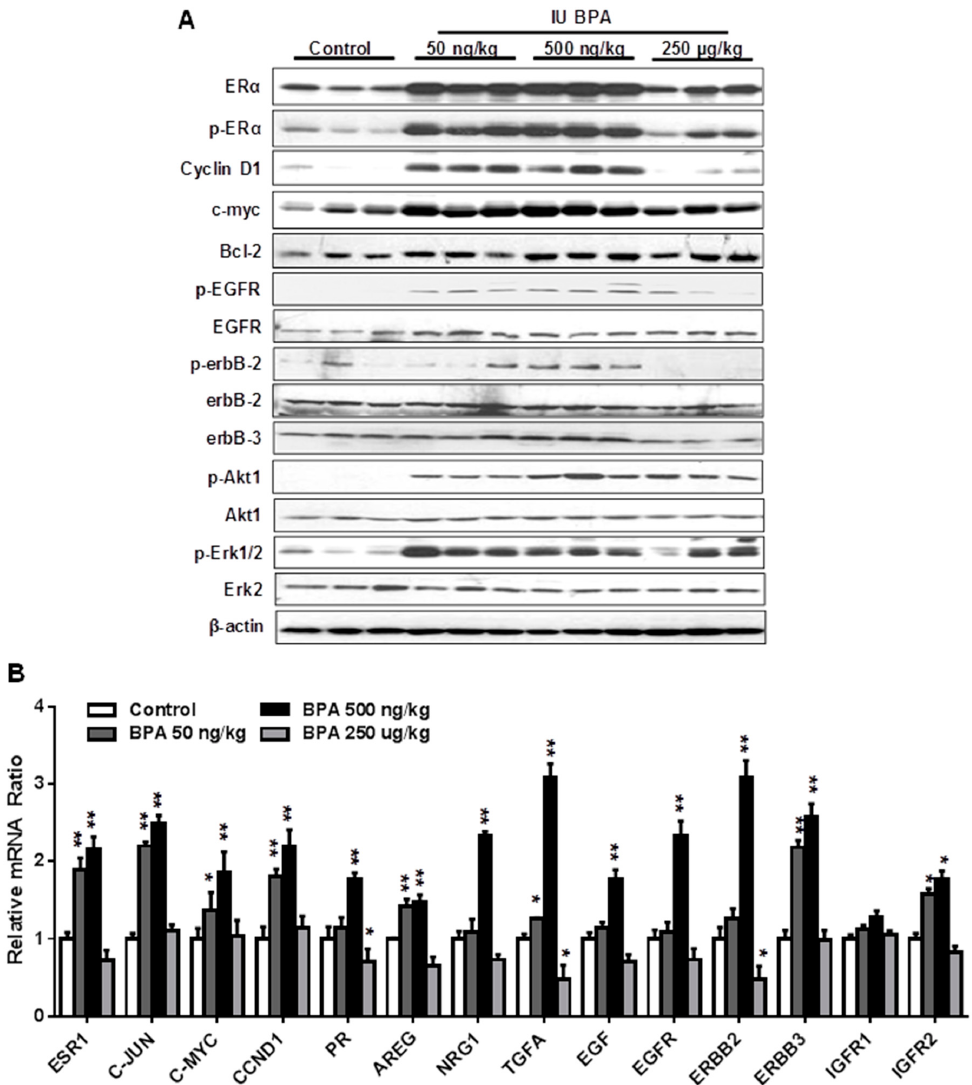
Figure 5. In utero exposure to low dose BPA induces concurrent activation of ER and EGFR / erbB2 pathways. ( A ) Western blot analysis of total and phosphorylated protein levels of indicated key regulators in ER and EGFR / erbB2 signaling pathways. Protein lysates were extracted from the mammary tissues of mice at PND 70 with di ff erent in utero BPA exposures, as detailed in the methods. ( B ) mRNA levels of genes involved in ER and RTK signaling in the mammary tissues of PND 70 mice with in utero exposure to indicated doses of BPA were quantified using real-time PCR. Each group was based on three samples from di ff erent mice with the same treatment (* p < 0.05; ** p <